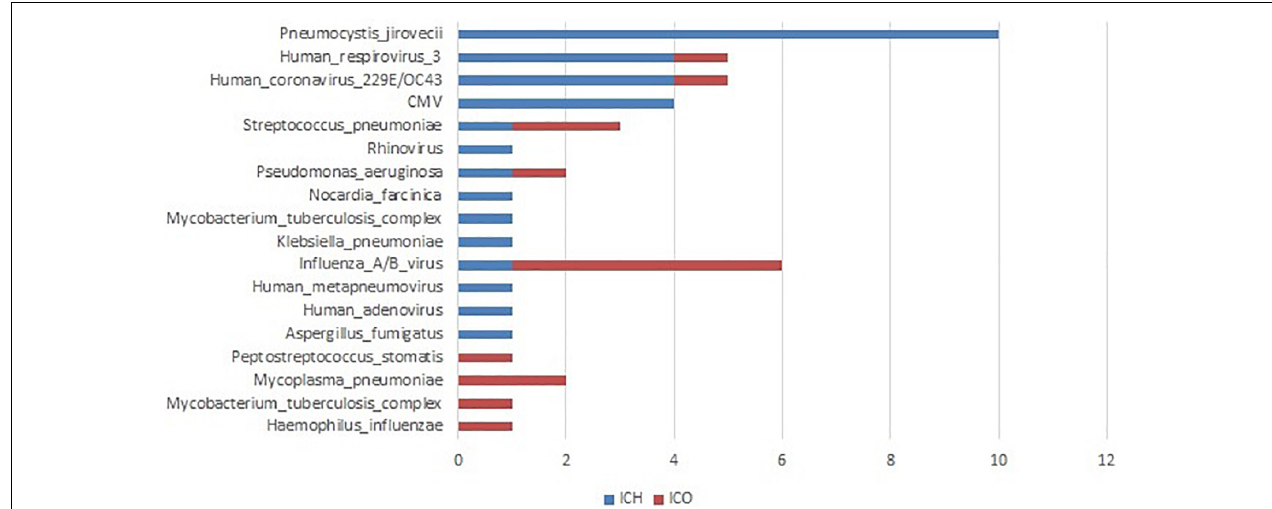
FIGURE 7 | Clinically determined pathogens only detected by PneumoSeq, not by conventional methods in pneumonia patients. ICH, immunocompromised host; ICO, immunocompetent host; CMV, cytomegalovirus.